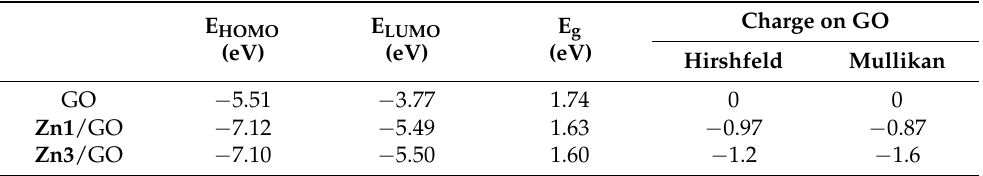
Table 3. Calculated HOMO energy (eV), LUMO energy (eV), energy gap energy (eV) and charges on GO calculated by Hirshfeld and Mullikan methods.